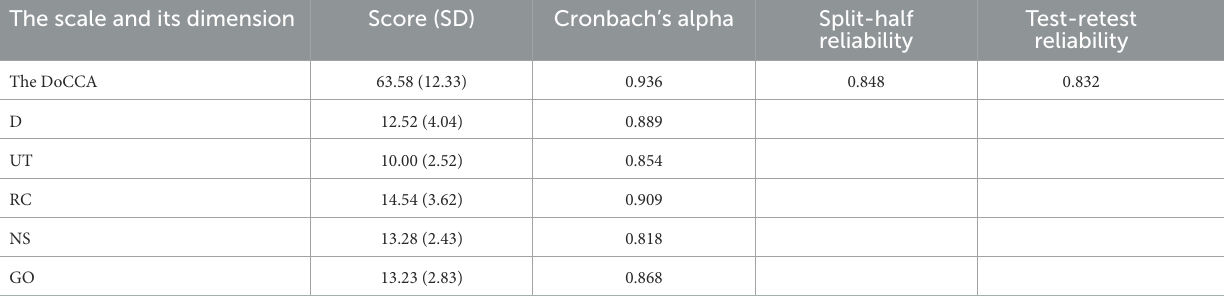
TABLE 7 Reliability analysis for Chinese DoCCA scale. The scale and its